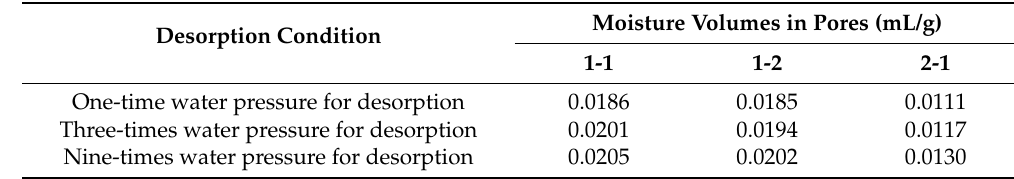
Table 6. Moisture volumes in pores under different water pressures